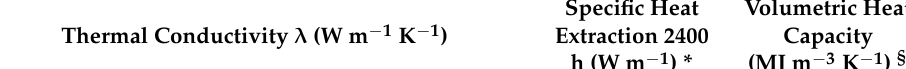
Table 1. Thermophysical properties for unconsolidated sediments and rocks of the investigated